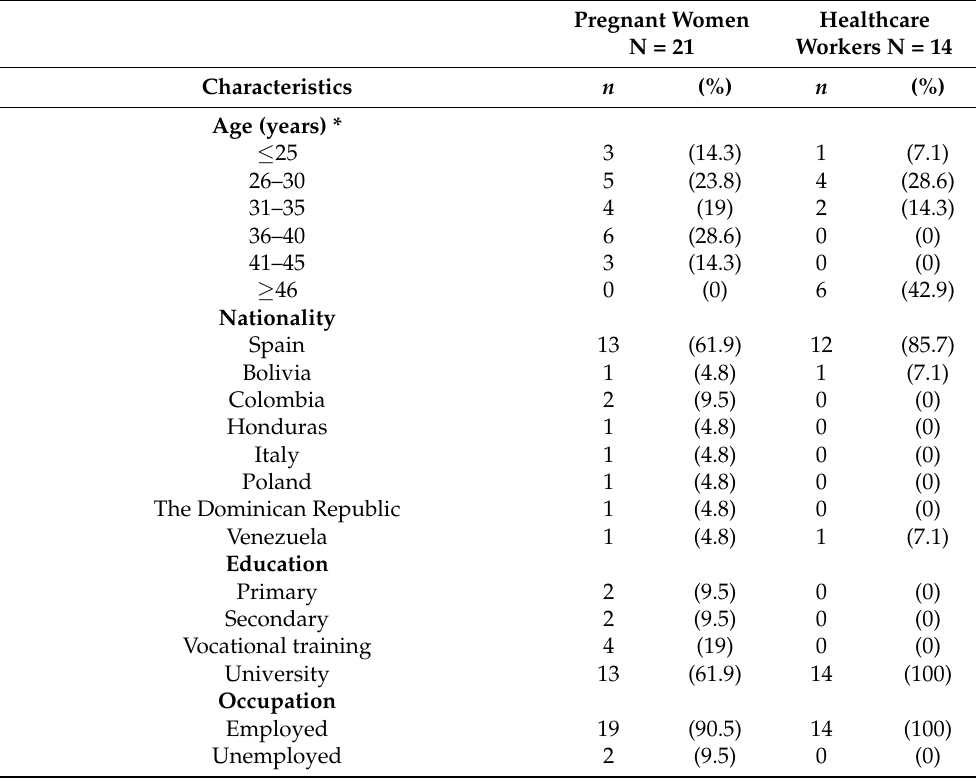
Table 1. Sociodemographic characteristics of pregnant women and HCWs